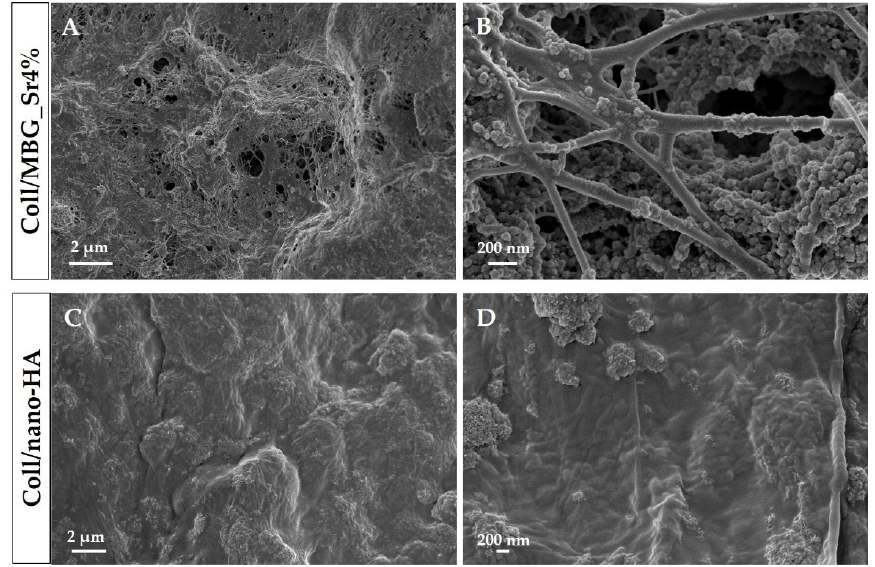
Figure 2. Cross-sectional FE-SEM images showing Coll/MBG_Sr4% and Coll/nano-HA samples at different magnifications.